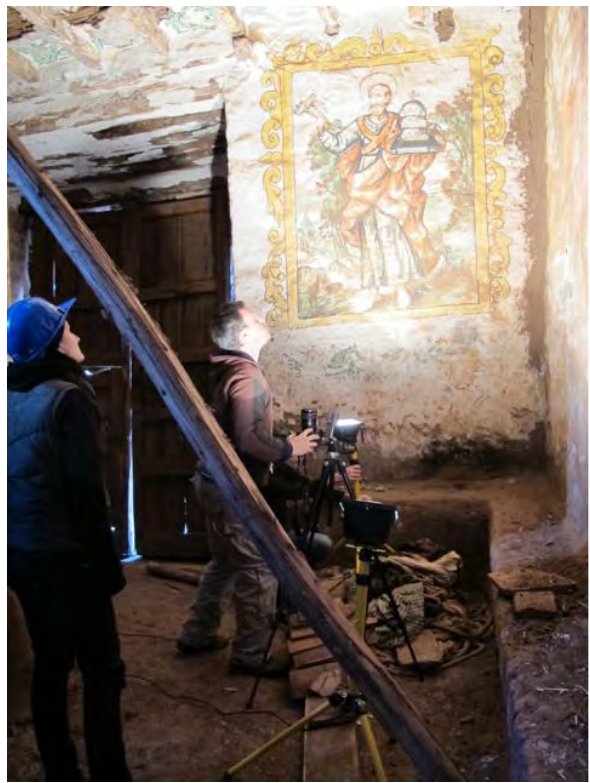
Figure 2. taking photograph using artificial